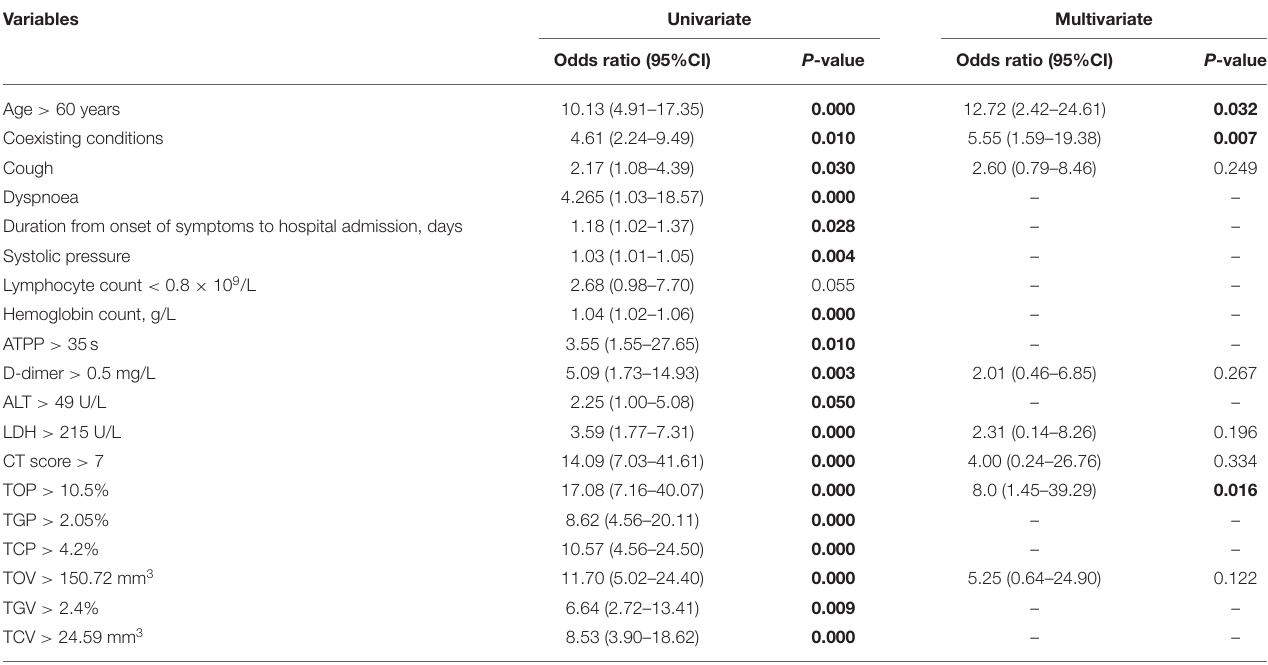
TABLE 4 | Univariate and multivariate analysis of clinical and imaging parameters for patients with ICU admission.